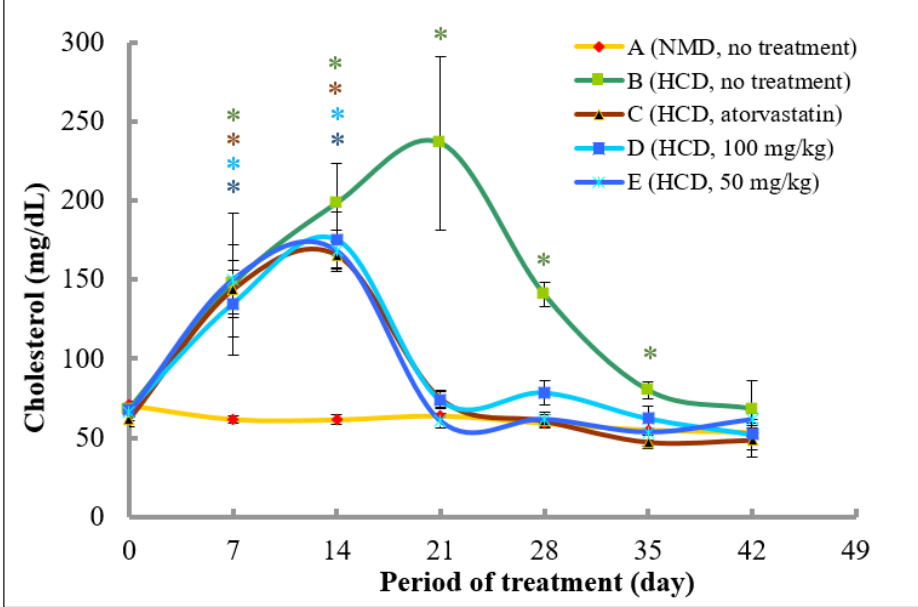
Figure 6. The changes of total cholesterol levels in rats fed with normal diet throughout 42 days of the experimental period. (A) Fed with normal diet for 14 days, followed by high fat diet for another 14 days, followed by normal diet until Day 42 (B); fed with high fat diet for 14 days, followed by normal diet together with atorvastatin for another 14 days, followed by normal diet without atorvastatin until Day 42 (C); fed with high fat diet for 14 days, followed by normal diet together with 100 mg/kg of methanolic extract for another 14 days, followed by normal diet without the extract until Day 42 (D); and fed with high fat diet for 14 days, followed by normal diet together with 50 mg/kg of methanolic extract for another 14 days, followed by normal diet without the extract until Day 42 (E). * denotes significantly different as compared to untreated control rats at Day 0 (negative control) of the respective group at p < 0.05.